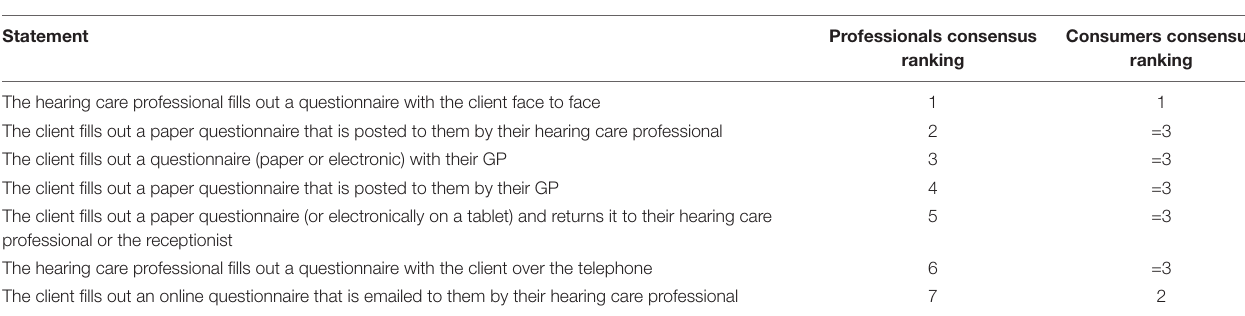
TABLE 6 | Rankings of methods of outcomes collection.